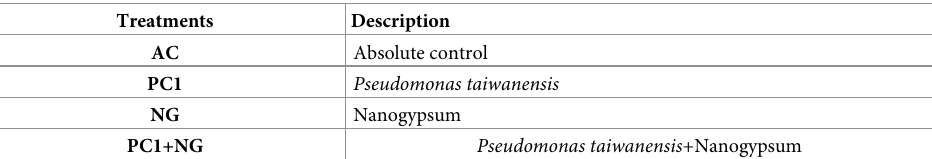
Table 1. Detail of the